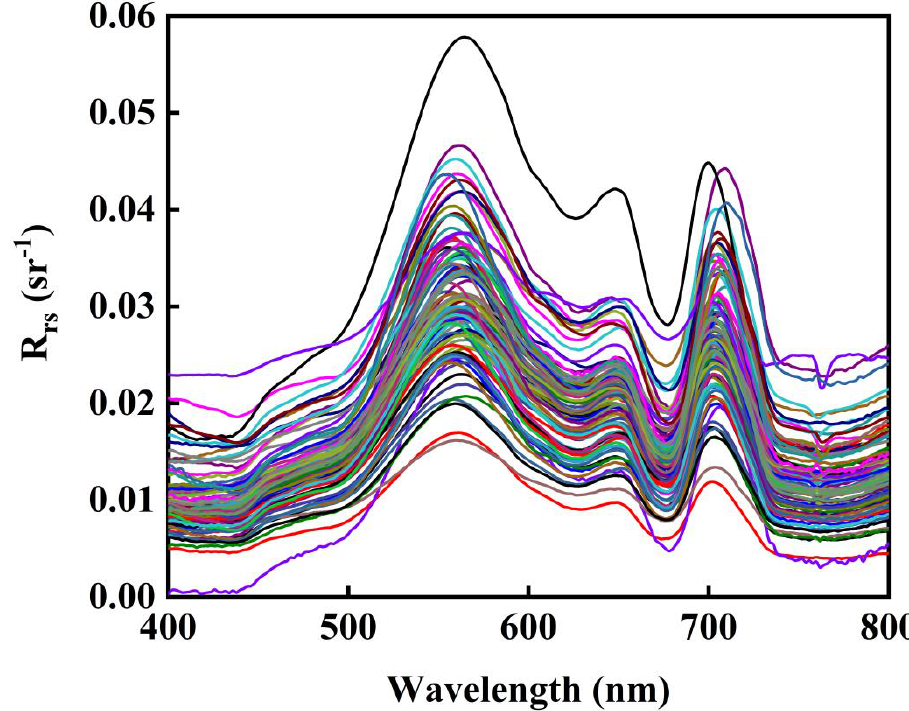
Figure 2. Spectral characteristics of field measurement sampling points. Each spectrum represents the remote sensing reflectance properties of each sampling point.